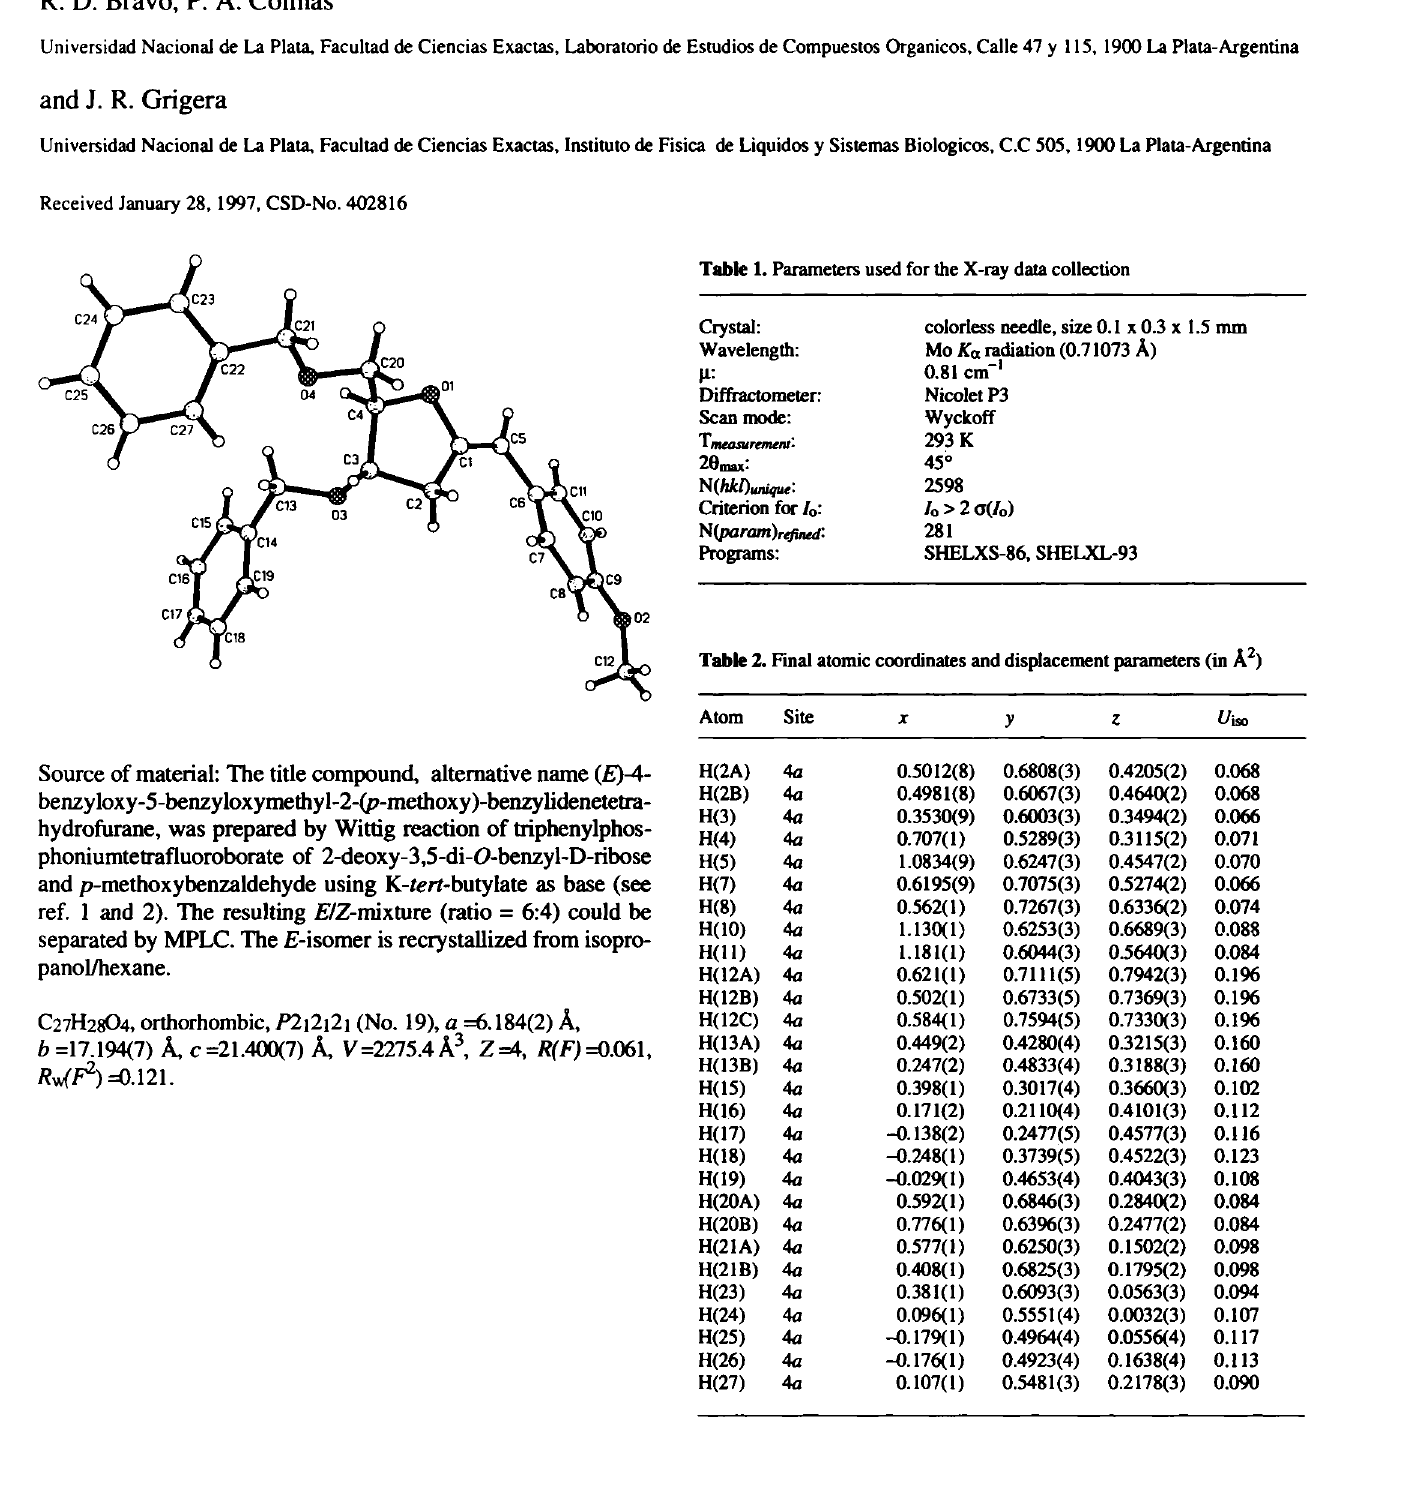
Table 1. Parameters used for the X-ray data collection